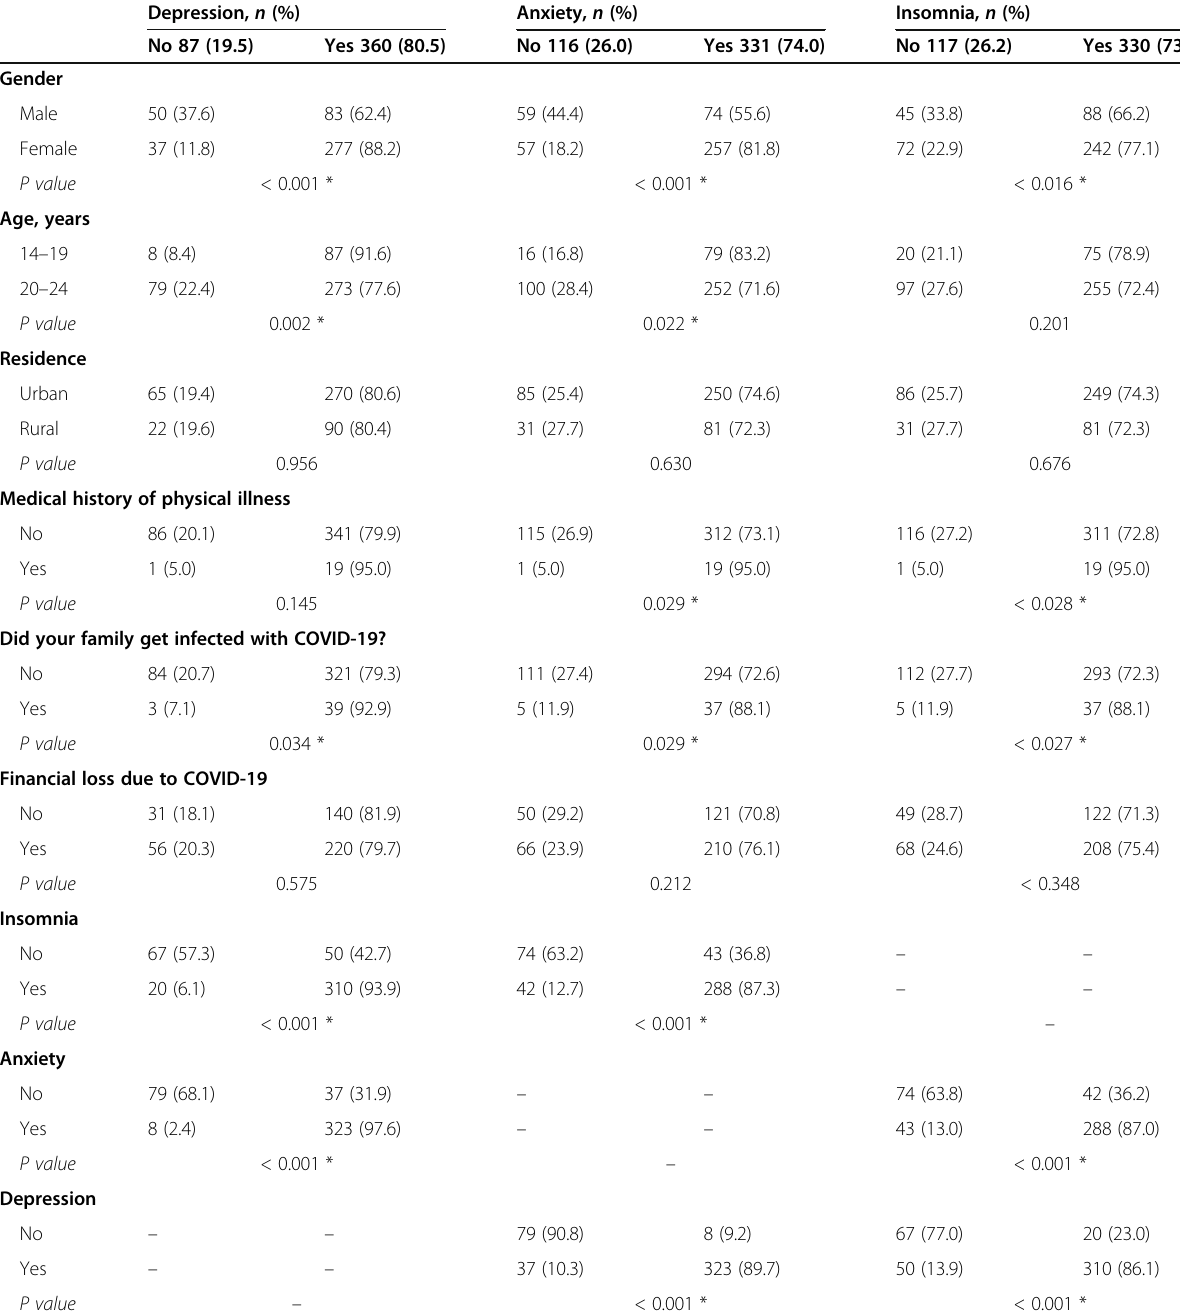
Table 3 Characteristics of the study participants by depression, anxiety, and insomnia symptoms ( n = 447) Depression, n